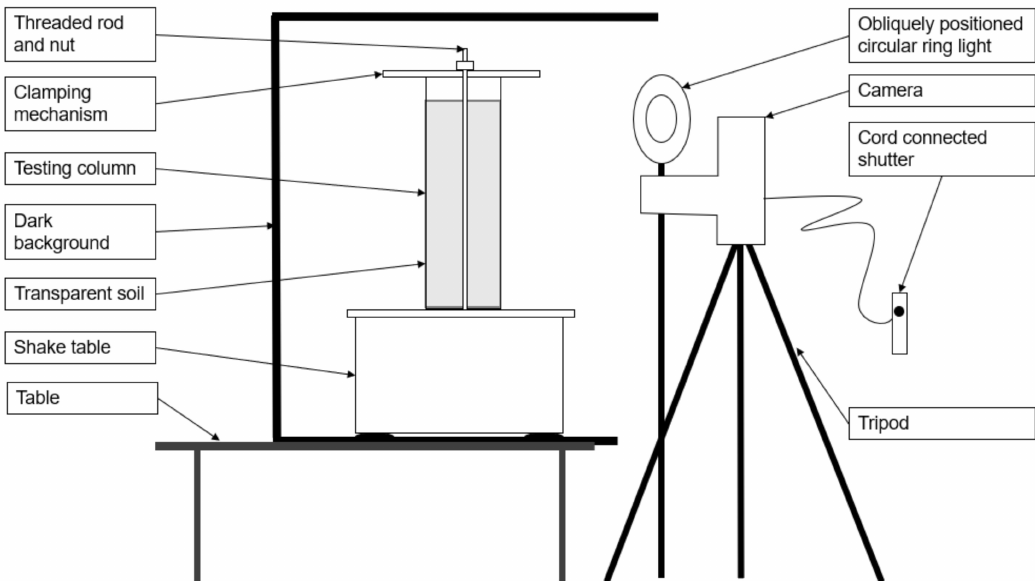
Figure 2. Experiment 1 setup—side